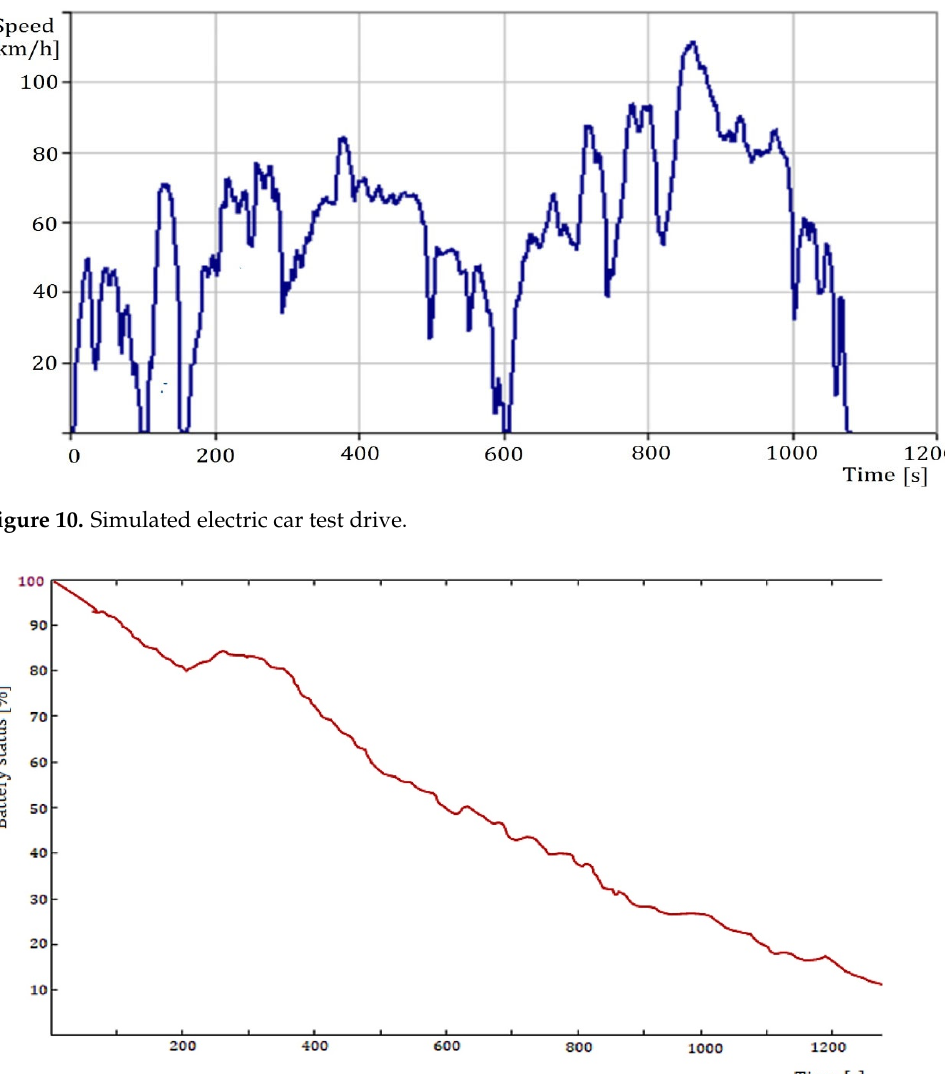
Figure 11. Graph showing the charge of the simulated battery for the chosen simulation time. After driving about 14 km, the state of charge is about 70%.